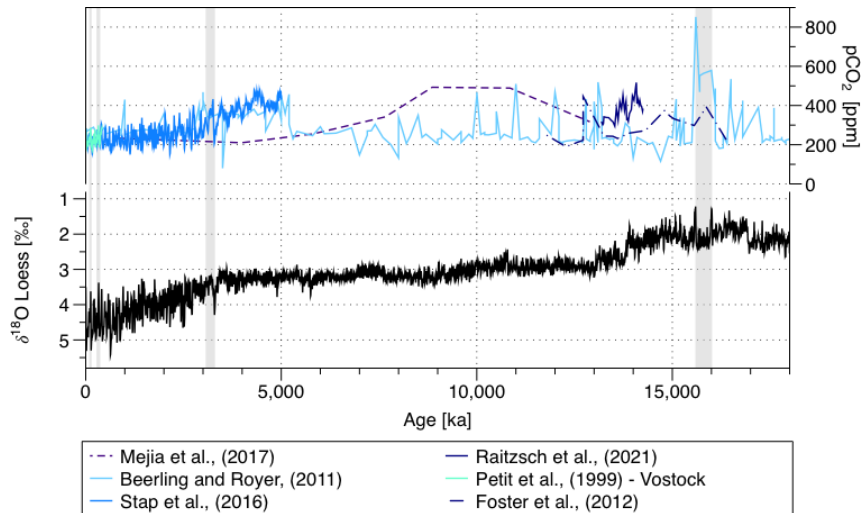
Figure 2. Oxygen stable isotopes ( δ 18 O) shown as a smoothed record (Loess) (Westerhold et al., 2020) and p CO 2 (Mejía et al., 2017; Beerling and Royer, 2011; Stap et al., 2016; Raitzsch et al., 2021; Foster et al., 2012; Petit et al., 1999) over the last 18000kyr and sampled intervals